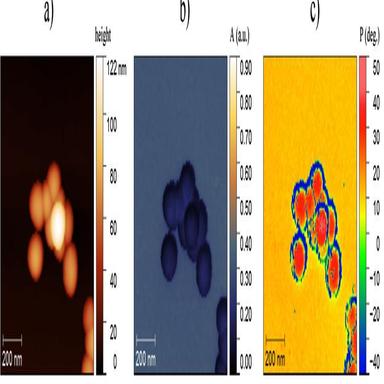
Silica nanoparticles doped with protoporphyrin IX (Si-NP PpIX); (a) AFM topography; (b) s-SNOM 3rd harmonic amplitude; (c) s-SNOM 3rd harmonic phase.